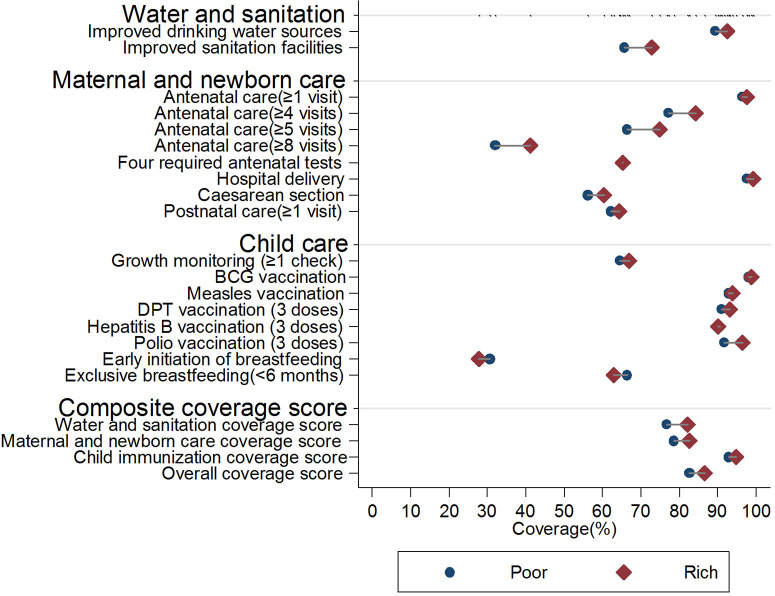
Equity gaps between poor and rich essential MNCH interventions, Jilin province, China (2008–2018). For details of the regression results for each specific intervention, please see Appendix 4.
In the water and sanitation domain, the interventions were adjusted for setting, household economic status, time to the nearest health facility, household head educational achievement, health insurance coverage, and ethnicity.In the maternal and newborn domain, the interventions were adjusted for setting, household economic status, time to the nearest health facility, mother's educational achievement, health insurance coverage, age when giving birth, parity, and ethnicity.In the child care domain, the interventions were adjusted for settings, household economic status, household head educational achievement, time to the nearest health facility, children's health insurance, age in months, sex, and ethnicity.Hospital delivery and BCG vaccination were not adjusted because the proportions were near 100%.